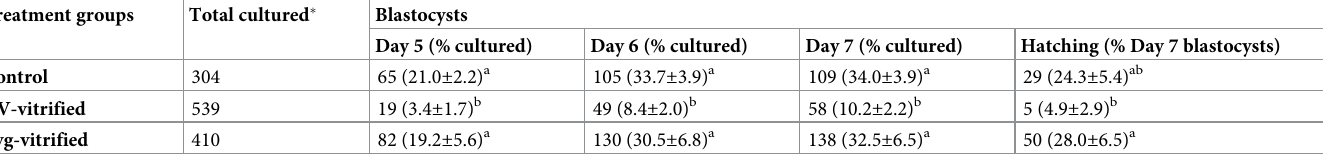
Table 3. In vitro development to the blastocyst stage of porcine oocytes vitrified either at the GV stage (GV-vitrified) or at the zygote stage (Zyg-vitrified). Treatment groups